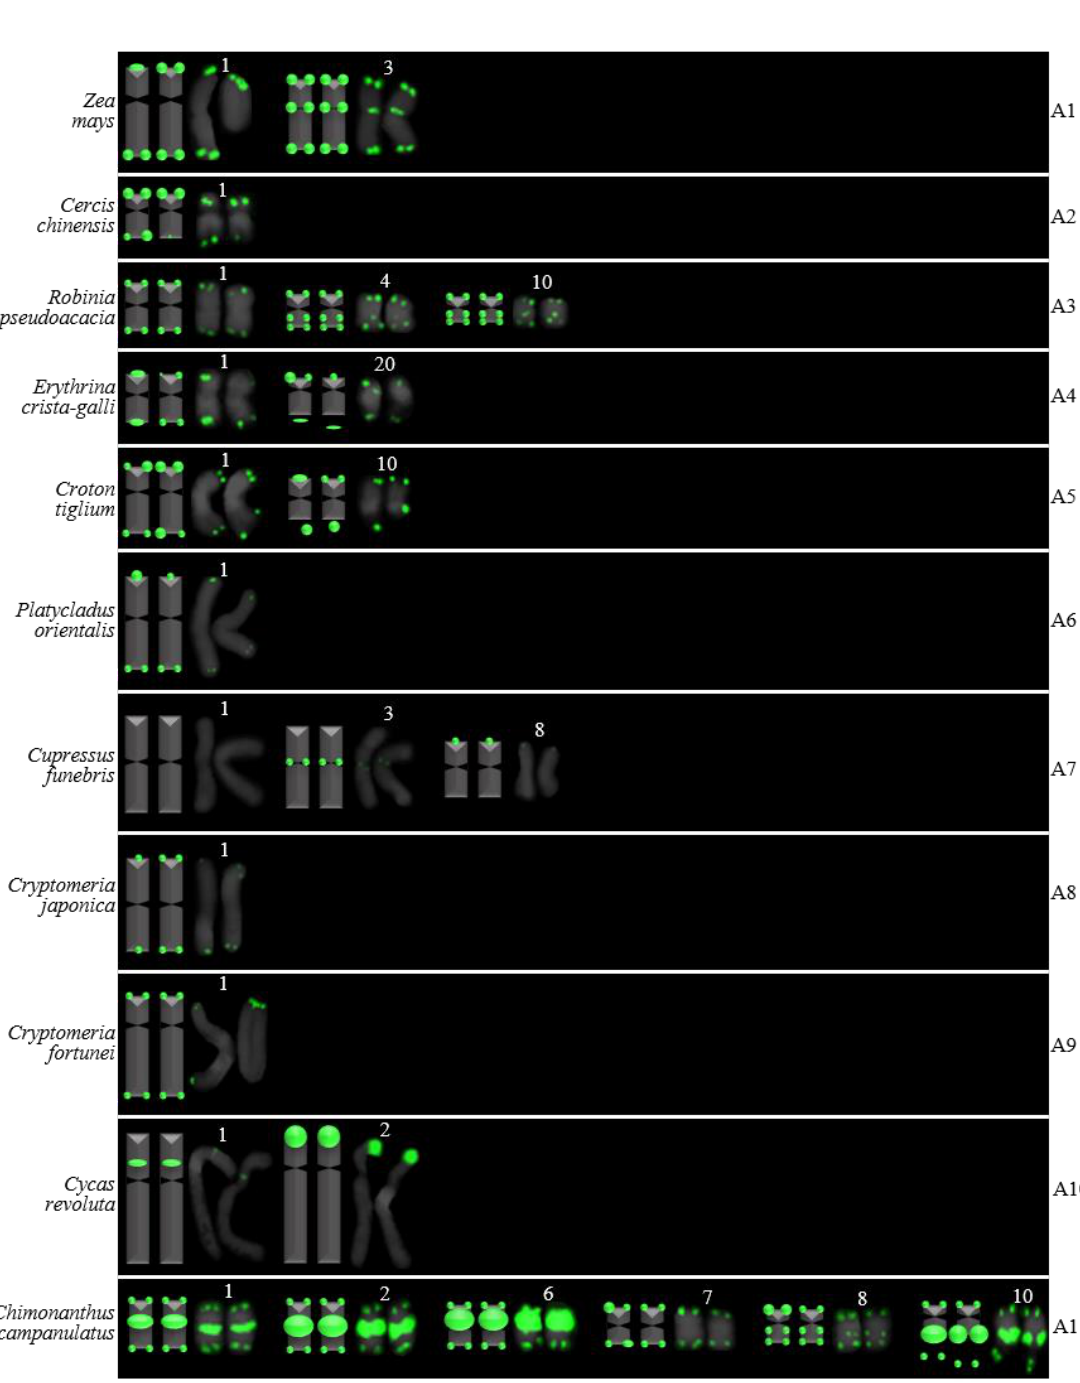
Figure 7. Ideograms of Z. mays and ten woody plants based on the signal patterns in the FISH karyograms shown in Figure 4: ( A1 ) Z. mays ; ( A2 ) C. chinensis ; ( A3 ) R. pseudoacacia ; ( A4 ) E. crista-galli ; ( A5 ) C. tiglium ; ( A6 ) P. orientalis ; ( A7 ) C. funebris ; ( A8 ) C. japonica ; ( A9 ) C. fortunei ; ( A10 ) C. revoluta